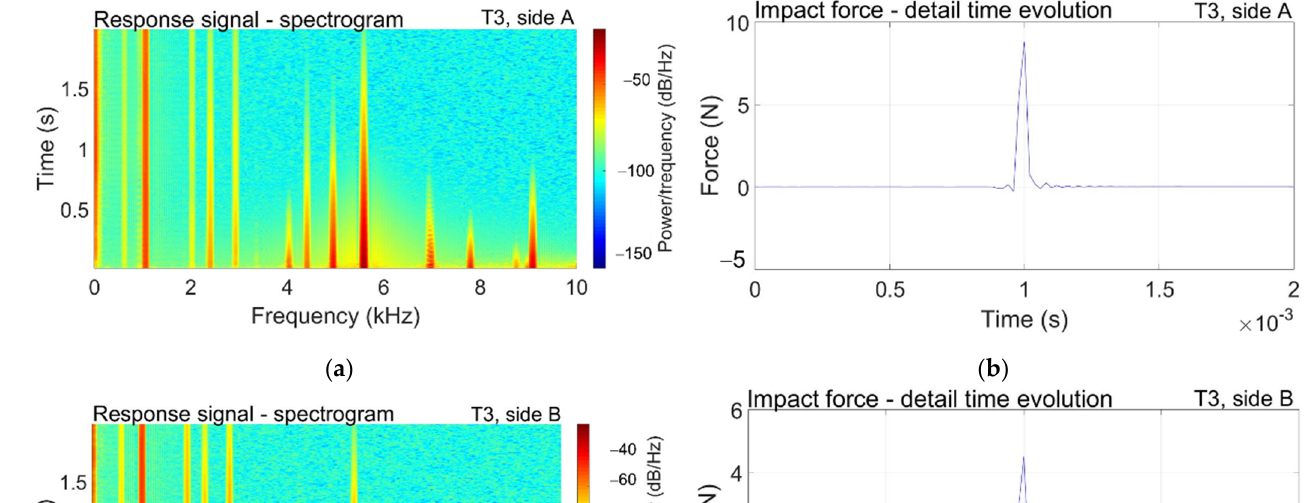
Figure 7. The spectrograms and the graphs of impact force, for aluminum triangle T2: ( a ) in case of excitation of side A; ( b ) the plot of excitation force against the time, by hitting side A; ( c ) in case of excitation of side B; ( d ) the plot of excitation force against the time, by hitting side B; ( e ) in case of excitation of side C; ( f ) the plot of excitation force against the time, by hitting side C.